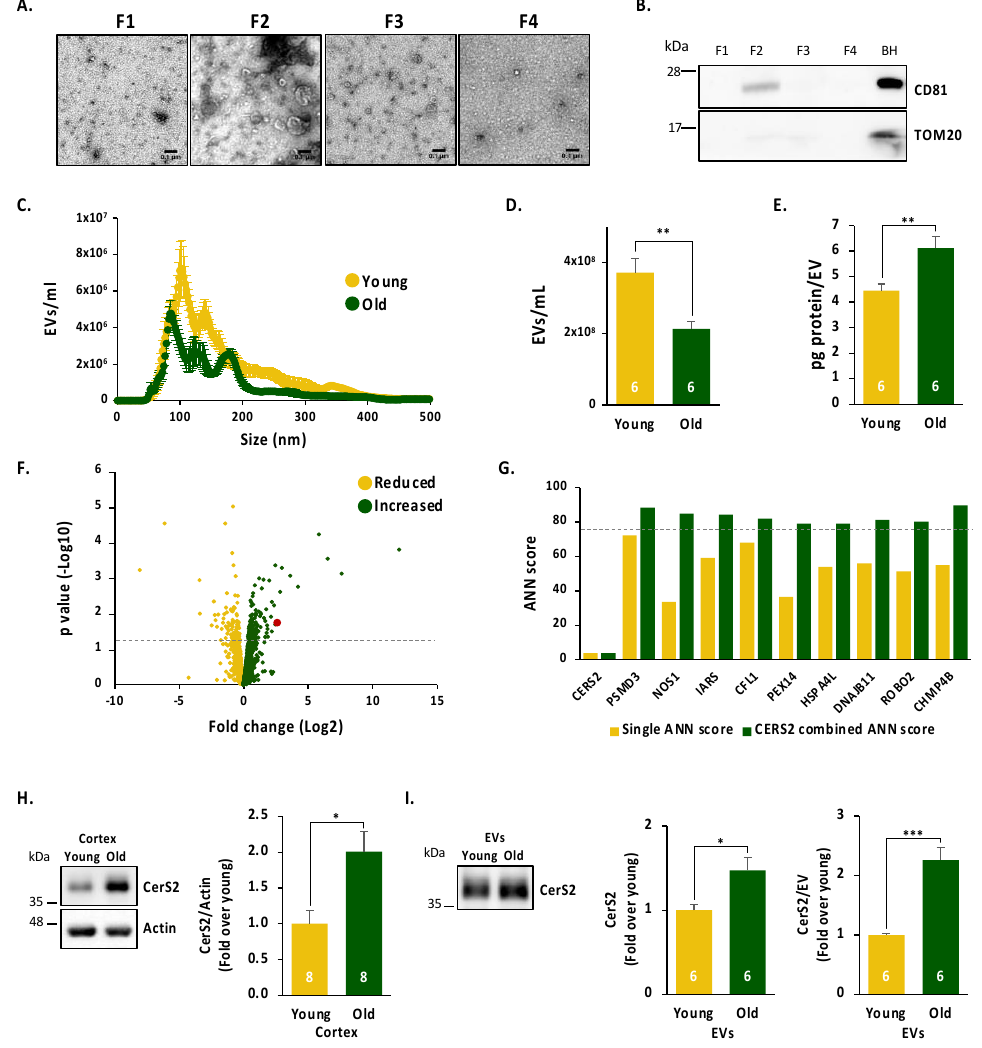
Figure 1. Characterisation of EVs isolated from young and old cortices: ( A , B ) electron microscopy ( A ) and WB ( B ) studies of the different fractions of the sucrose gradient phases showing EVs are found in fraction 2. ( C , D ) Nanosight analysis of young and old EVs from cortical regions showing the distribution size ( C ) and the number of total EVs ( D ) showing that the total number of EVs is reduced in the ageing cortex. ( E ) Quantification of protein per EV in cortical EVs from young and old cortices shows that aged EVs present higher protein levels. ( F ) Volcano plot of proteins up- and downregulated in aged cortical EVs. CerS2 is indicated in red. The dotted line indicates p -values < 0.05. ( G ) Bioinformatic analysis based on artificial neural networks (ANN) for the synergic effect of CERS2 and different proteins predicted in relation to apoptosis. An ANN scores greater than 78 predicts some function in apoptosis. The dotted line indicates scores above 78. ( H ) Representative images for Western blot ( left ) and quantification ( right ) of CerS2 in young and old mice cortex homogenates showing increased total levels of CerS2 in the ageing cortex. ( I ) Representative images for Western blot ( left ) and quantification for CerS2 ( middle ) and CerS2 per EV ( right ) in young and old mice cortex-derived EVs showing increased levels of CerS2 and CerS2 levels per EV. Student t -test. * p -value < 0.05, ** p -value < 0.01, *** p -value < 0.001.